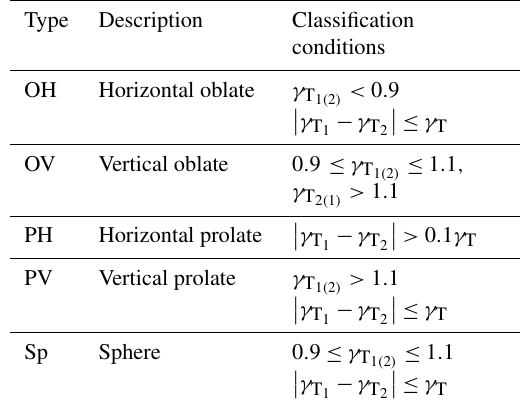
Table 1. Ash particle classification